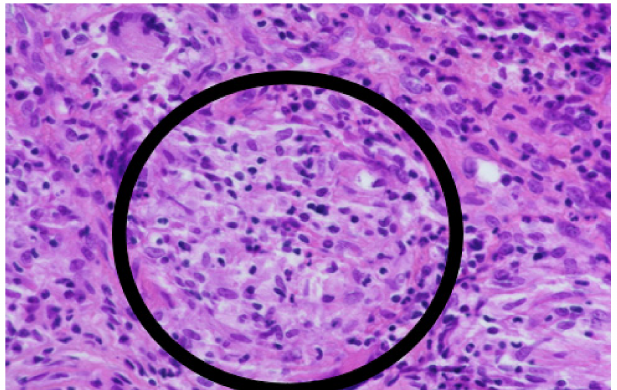
Figure 3. Epitheloid histiocytes and multinucleated giant cells of Langerhans’ type forming specific granulomatous tissue. Some neutrophils in the center of granulomas can be identified. However, no caseous necrosis is present (400 × ).